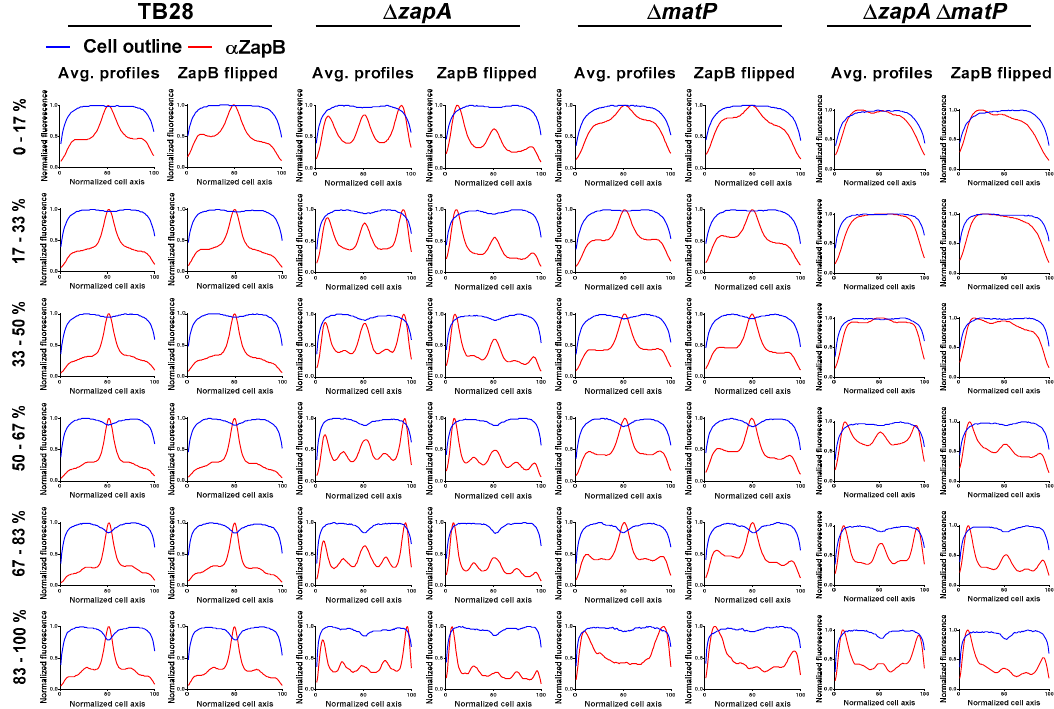
Figure 6. ZapA is the main factor affecting ZapB. localization at midcell. The cells were grown in rich medium at 37 ° C, fixed, and immunolabeled with antiZapB. Average fluorescence profiles (red) and diameter profiles (blue) in 17% age classes of TB28, ∆ zapA , ∆ matP or ∆ zapA ∆ matP are shown from left to right, respectively. For each sample the random orientation and the ZapB intensity-based orientation are shown. Absence of MatP had minor effects on ZapB midcell localization but ZapB signals localized more throughout the cell. The full fluorescence profile maps are shown in Figure S6. The respective number of analyzed cells for TB28 ∆ zapA , ∆ matP or ∆ zapA ∆ matP were: 1504, 906, 759, and 831.